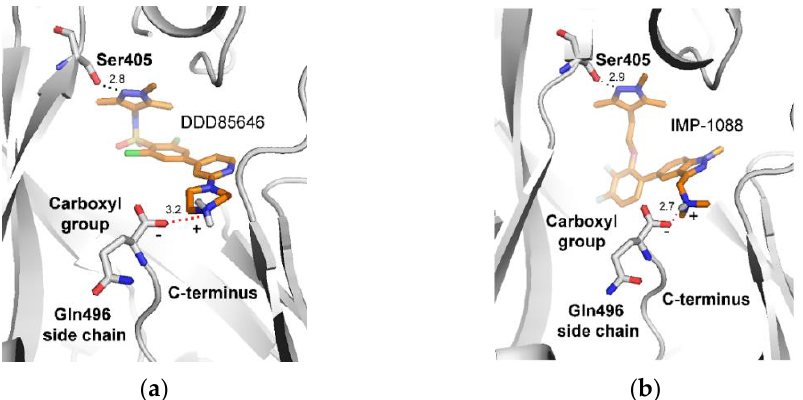
Figure 2. Formation of a salt bridge between the positively charged moiety of the NMT inhibitors and the C-terminus of the NMT1 protein based on: ( a ) the crystal structure of Homo sapiens NMT1 in a complex with DDD85646 (PDB 3IWE) [12]; ( b ) the crystal structure of Homo sapiens NMT1 in a complex with IMP-1088 (PDB 5MU6) [13]. The carbon atoms of the inhibitors are shown in orange. The salt bridge is depicted by red dots. The corresponding charges of the inhibitors and of the carboxyl group at the C-terminus are also indicated. Distances shown are in angstroms (Å ).